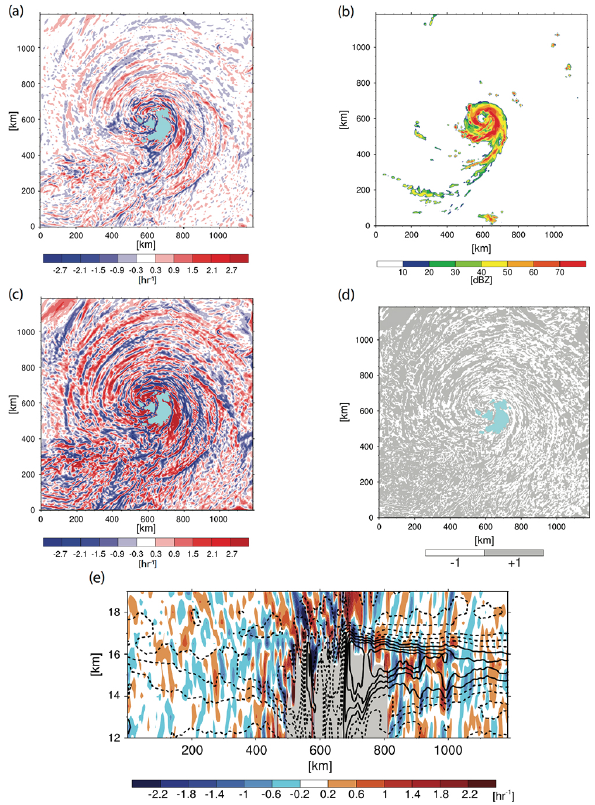
Fig. 2. (a) HDTGW at 16kma.g.l., (b) radar reflectivity at 400 hPa, (c) total horizontal divergence at 16kma.g.l. at 03:00UTC, 9 Au- gust, and (d) phase difference between the total horizontal diver- gence and HDTGW shown in (a) and (c) . In (d) , gray and white regions denote in phase and out of phase between (a) and (c) , re- spectively. Note that blue color denotes cloud-covering area in (a) , (c) , and (d) . (e) x – z cross section of zonal wind (contour) superim- posed on HDTGW (shaded) at y =600km on 03:00UTC, 9 August. Gray shaded region shows cloud-covering area. In (e) , solid and dashed contours denote positive and negative values, respectively, with 6ms − 1 intervals from − 21ms − 1 to 21ms − 1